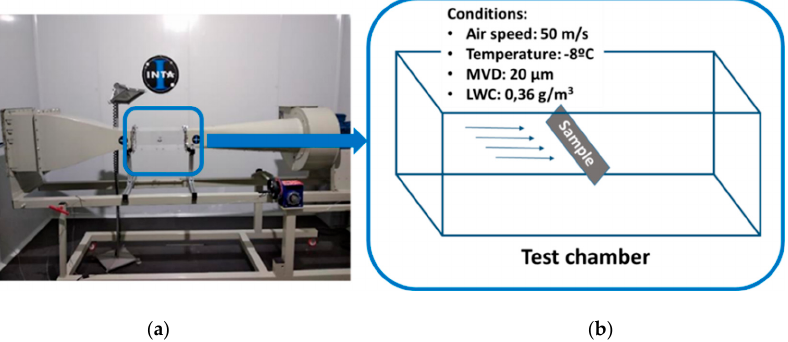
Figure 1. INTA’s laboratory scale IWT ( a ) and test chamber scheme including the employed test condition ( b ). LWC: liquid water content; MVD median volume diameter. condition ( b ). LWC: liquid water content; MVD median volume